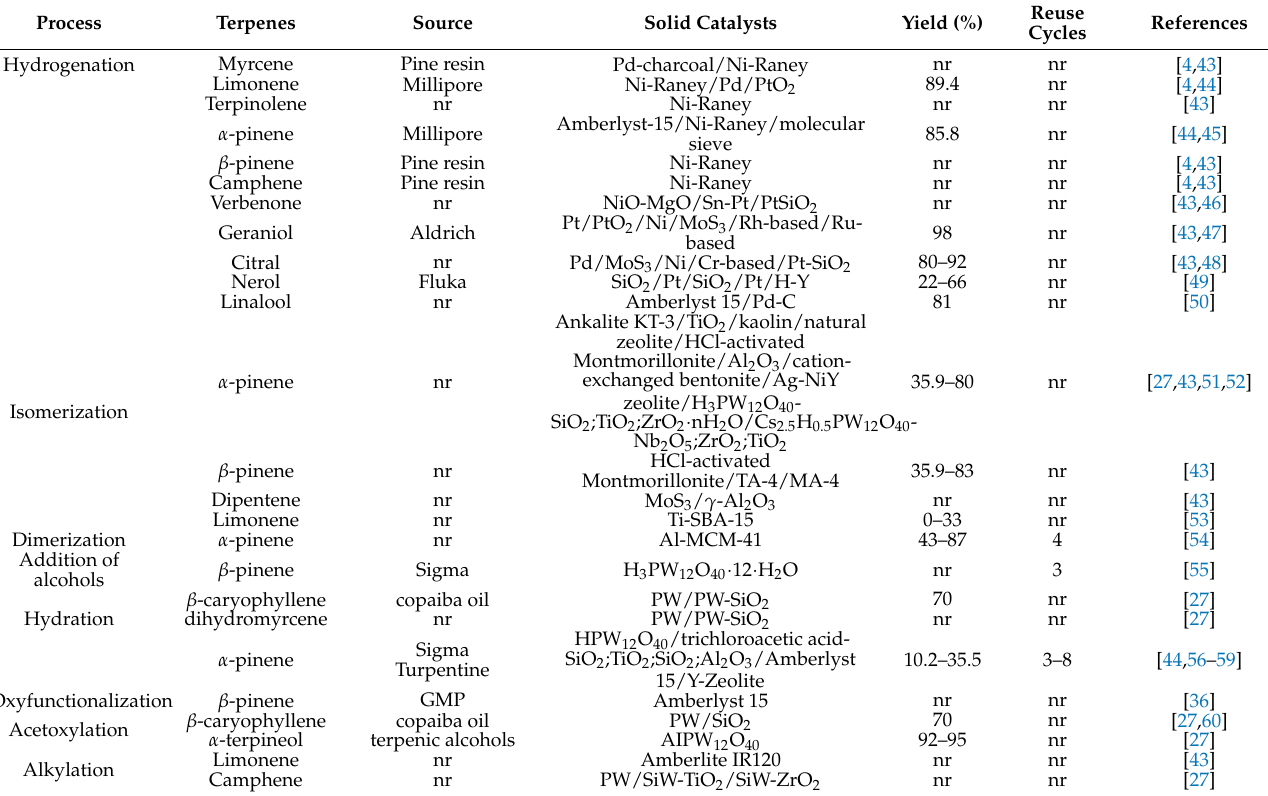
Table 2. Transformation of terpenes using solid